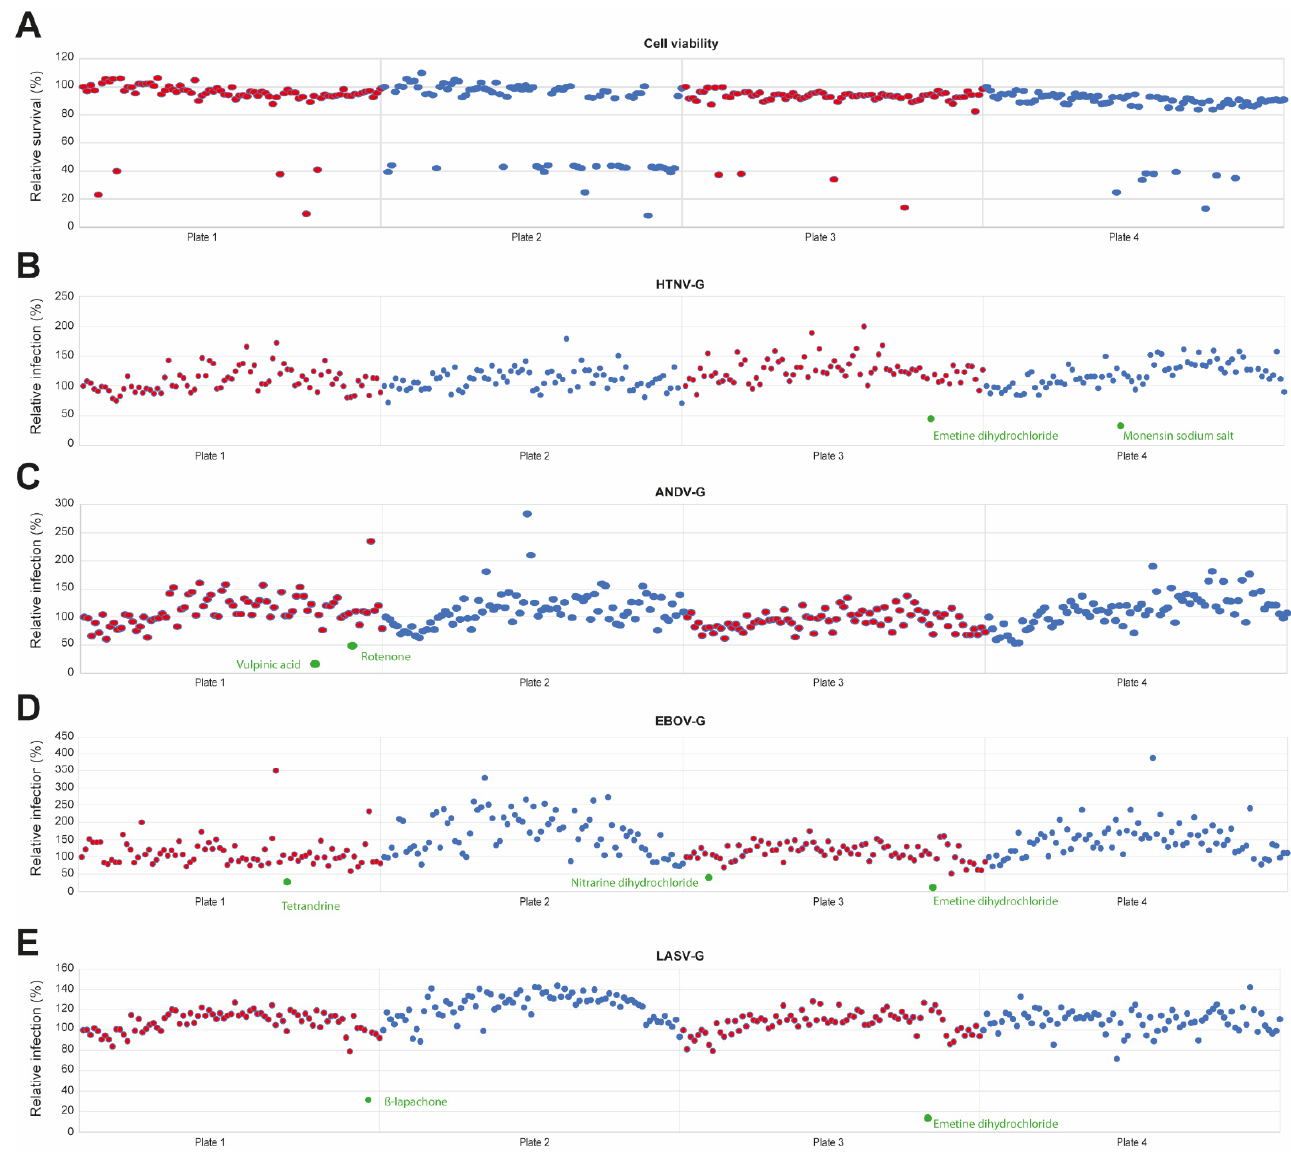
Figure 3. Screening of Prestwick Phytochemical library identified compounds reducing pseudoviruses entry. A549 cells were pre-treated with 10 μ M of compounds for 45 min and infected with VSV* Δ G-Luc(HTNV-G), VSV* Δ G-Luc(ANDV-G), VSV* Δ G-Luc(EBOV-G) or VSV* Δ G-Luc(LASV-G) in presence of the drugs. After 2 h, cells were washed 3 times with medium containing 20 mM ammonium chloride, followed by 16 h of incubation in the presence of the lysosomotropic agent. Infection was detected by EGFP and the control (DMSO) set at 100%. ( A ) Cell viability was measured by the CellTiter-Glo ® assay. The compounds demonstrating a reduction of >20% in cellular ATP levels were considered toxic. ( B – E ) Infection was detected by EGFP expression and the control (DMSO) set at 100%. The compounds reducing viral entry by >50% are highlighted in green and names wrote underneath.